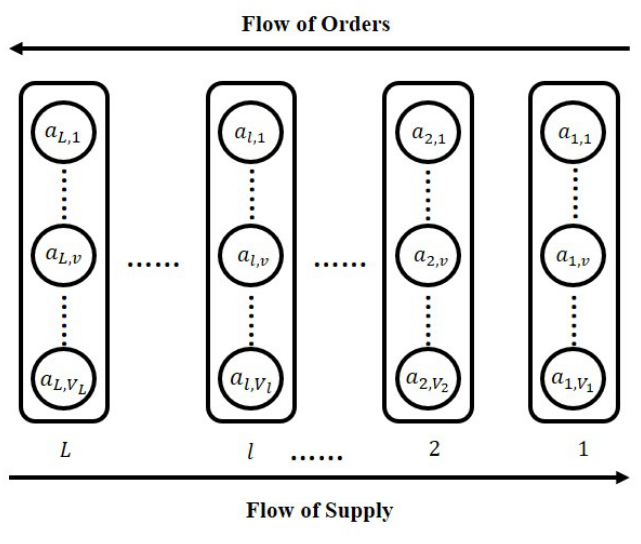
Figure 3. The ABM-ESC model.